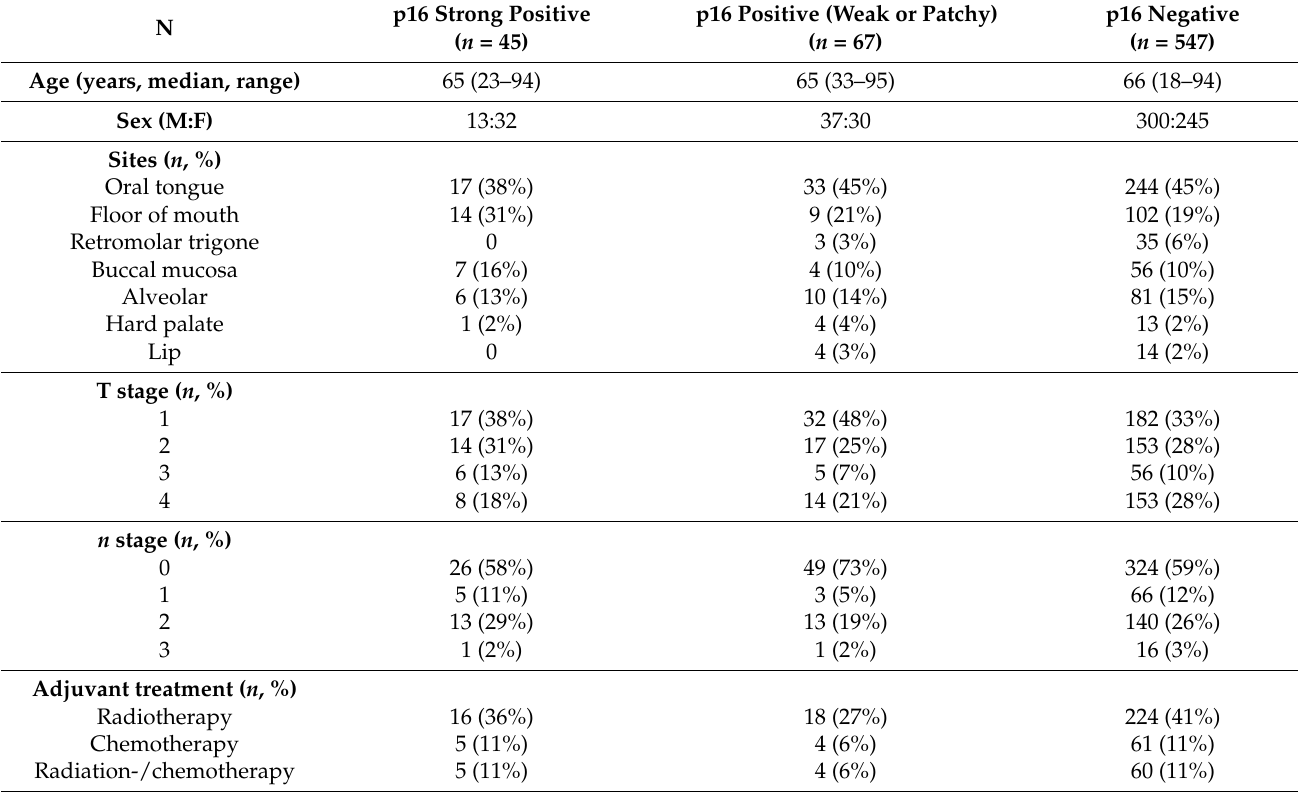
Table 2. Demographics by p16 immunohistochemical